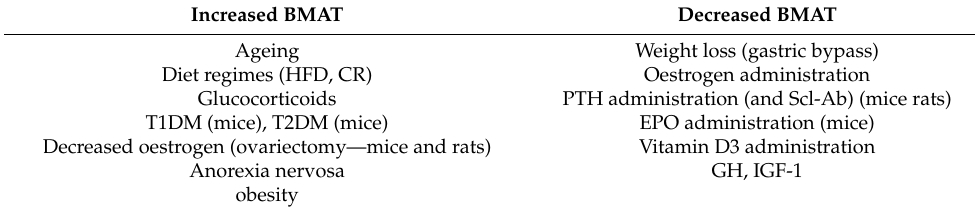
Table 1. BMAT in various conditions [66–68,78]. Increased BMAT Decreased BMAT Ageing Weight loss (gastric bypass) Diet regimes (HFD, CR) Oestrogen administration Glucocorticoids PTH administration (and Scl-Ab) (mice rats) T1DM (mice), T2DM (mice) EPO administration (mice) Decreased oestrogen (ovariectomy—mice and rats) Vitamin D3 administration Anorexia nervosa GH, IGF-1